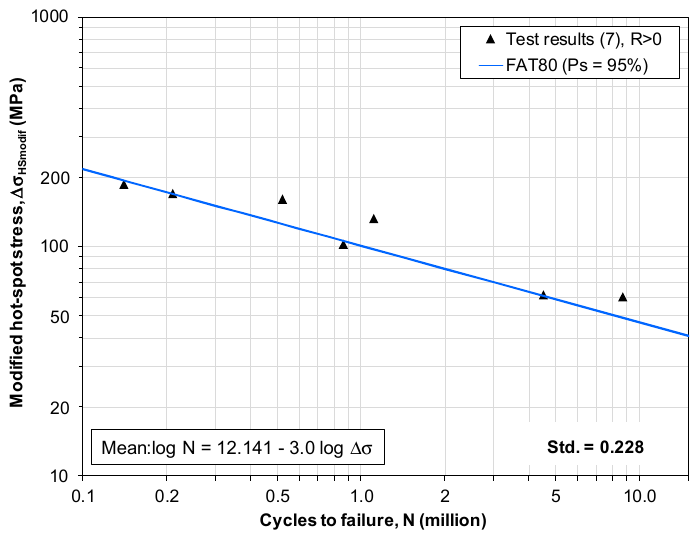
Figure 14. Modified hot-spot S-N curve for transverse web stiffener (refer to Figure 12a).